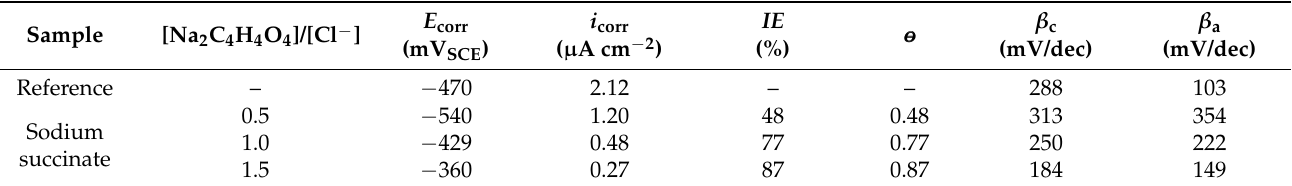
Table 5. PDP curves electrochemical parameters for carbon steel in the presence and absence of different concentrations of sodium succinate at 25 °C.